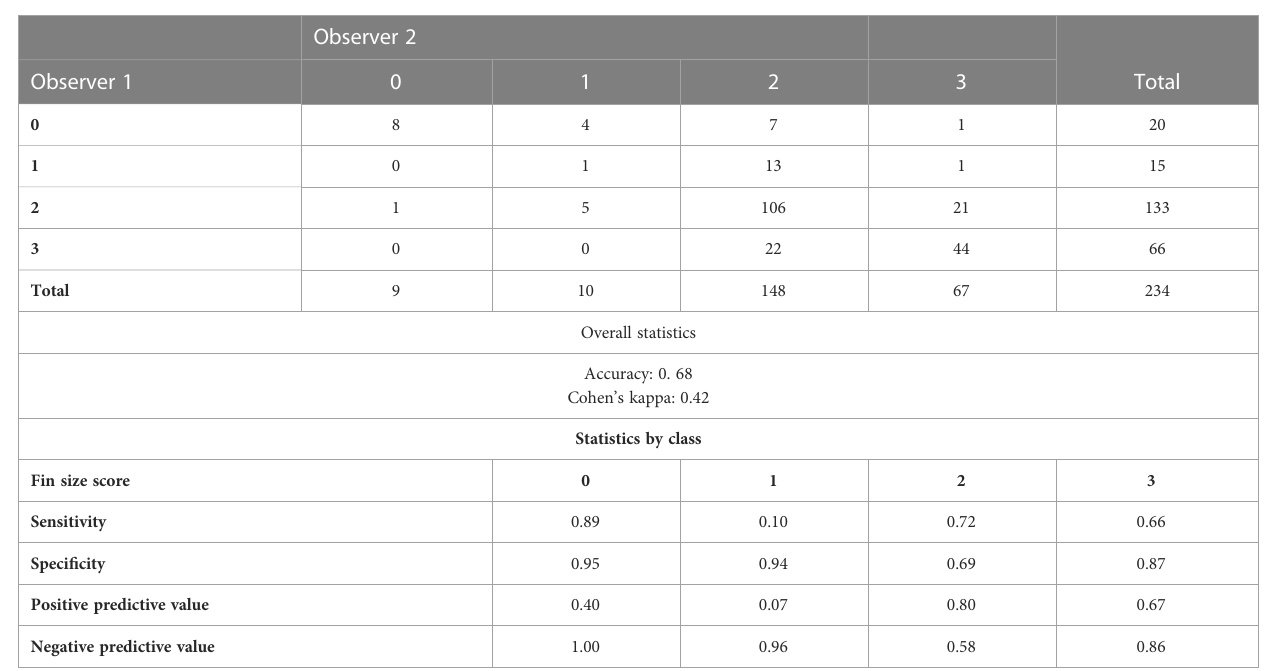
TABLE 5 Confusion matrices for fi n size scores between the two human observers for 234 post-smolt Atlantic